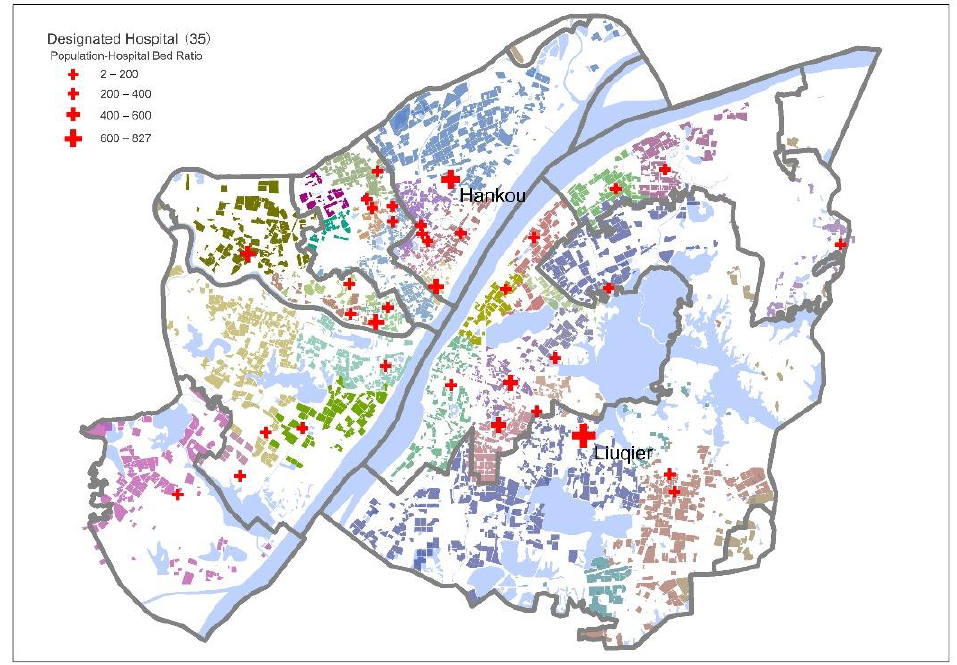
Figure 9. Service areas (in different colors) and population–hospital bed ratios (in different size) of the designated hospitals.